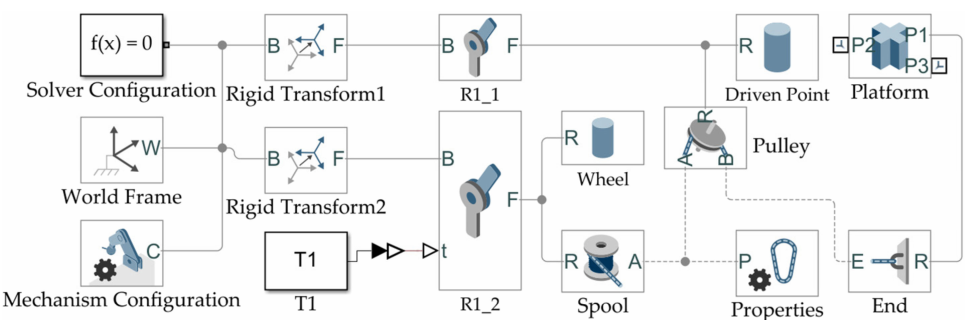
Figure 6. The construction of the cable-driven unit model.